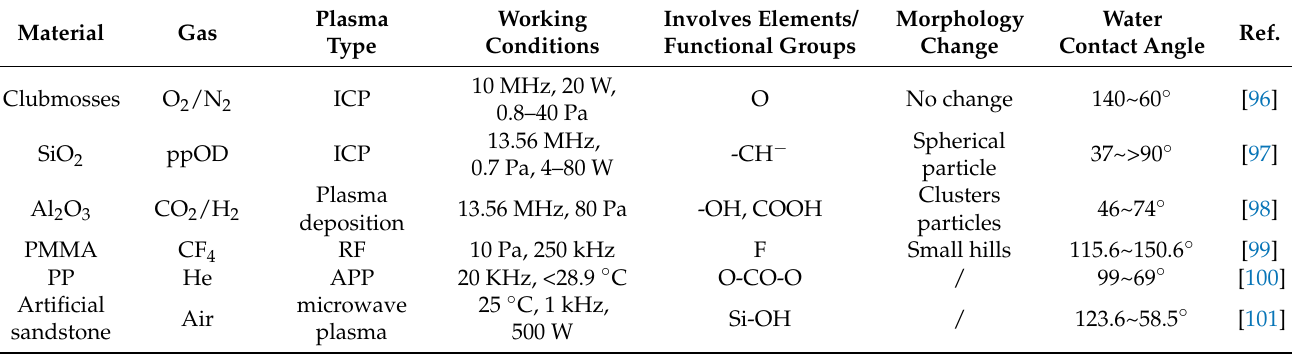
Table 6. Plasma treatment of particle